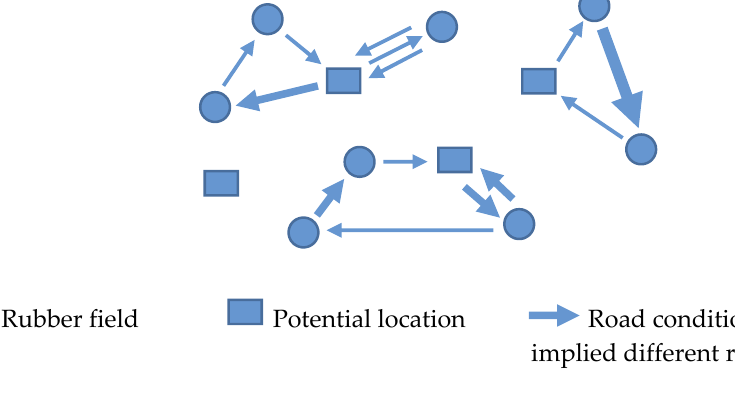
Figure 1. The problem definition.